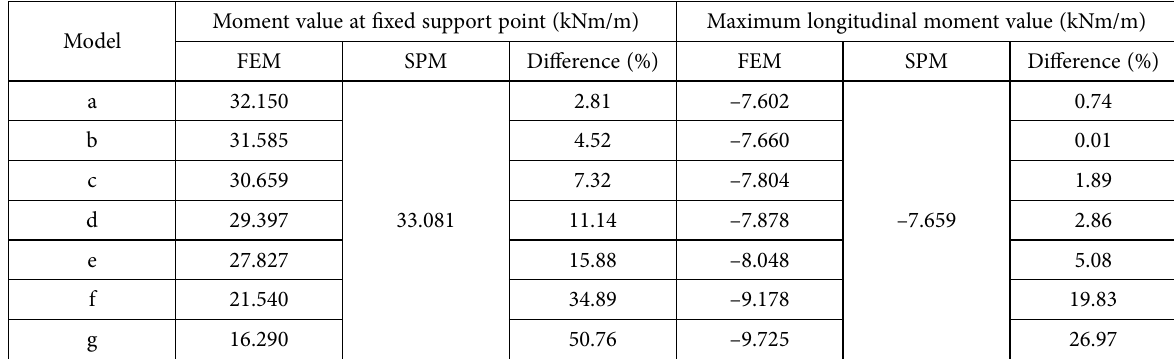
Table 2. The difference between FEM and SPM for different aspect